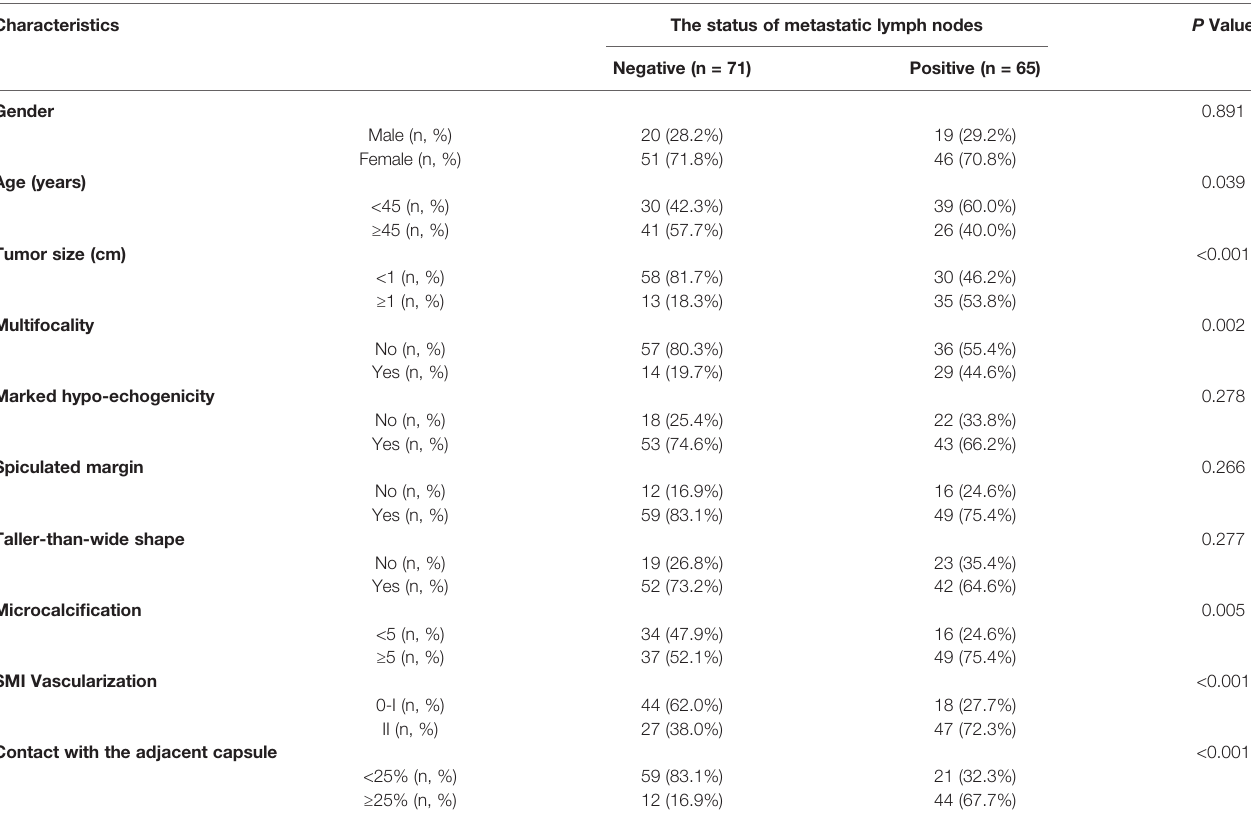
TABLE 2 | Ultrasonographic characteristics of PTCs.